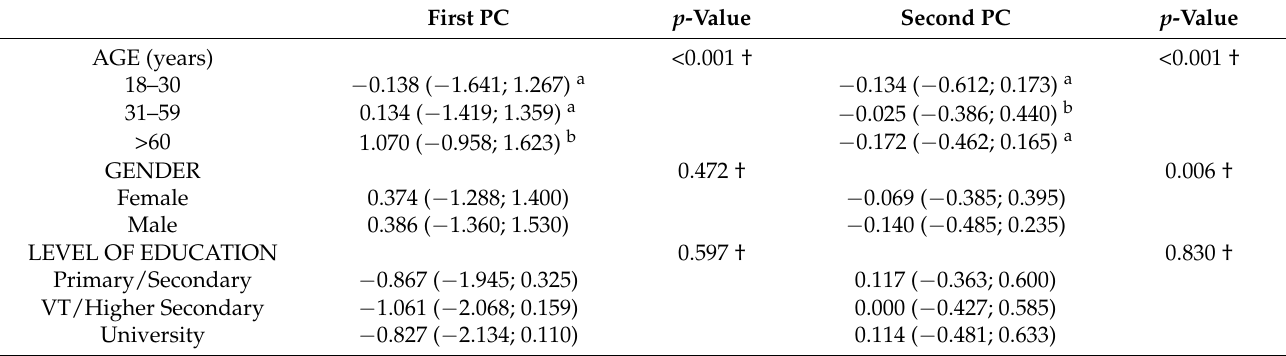
Table 7. Associations between the characteristics of consumers and